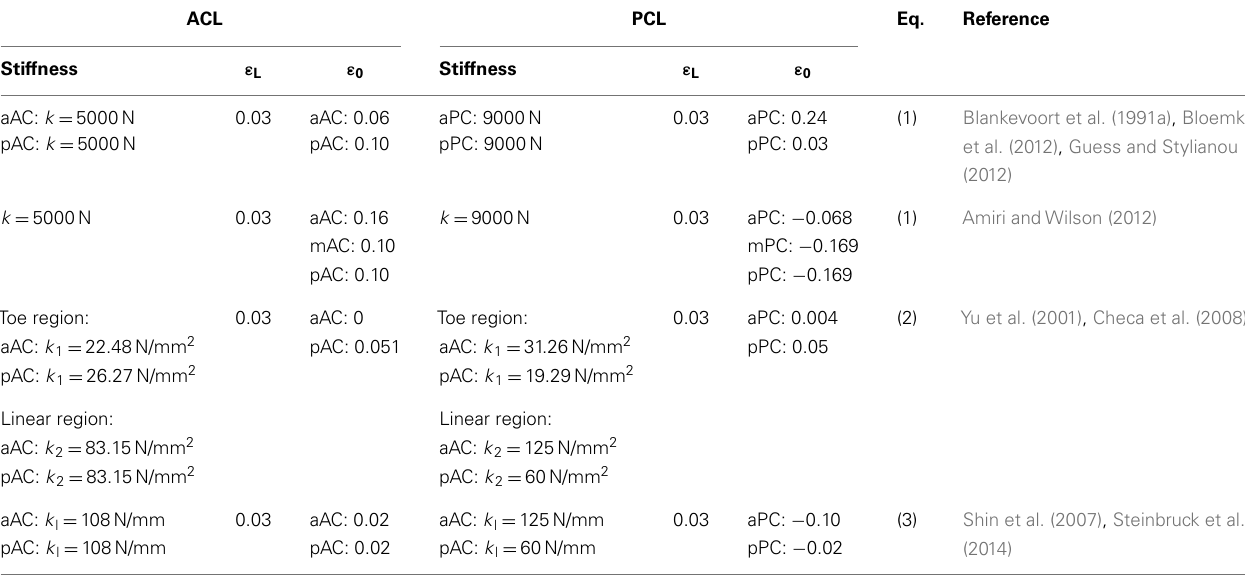
Table 1 | Material properties used to model the non-linear behavior of theACL and PCL with non-linear 1D elements